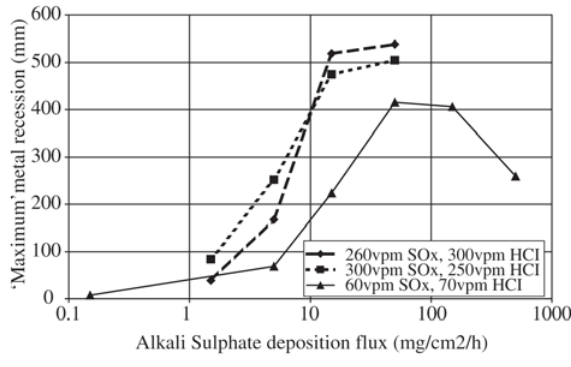
Figure 6. Effect of alkali sulphate flux and gaseous reactants on ‘maximum’ metal damage recession of IN738LC at 700 °C 29